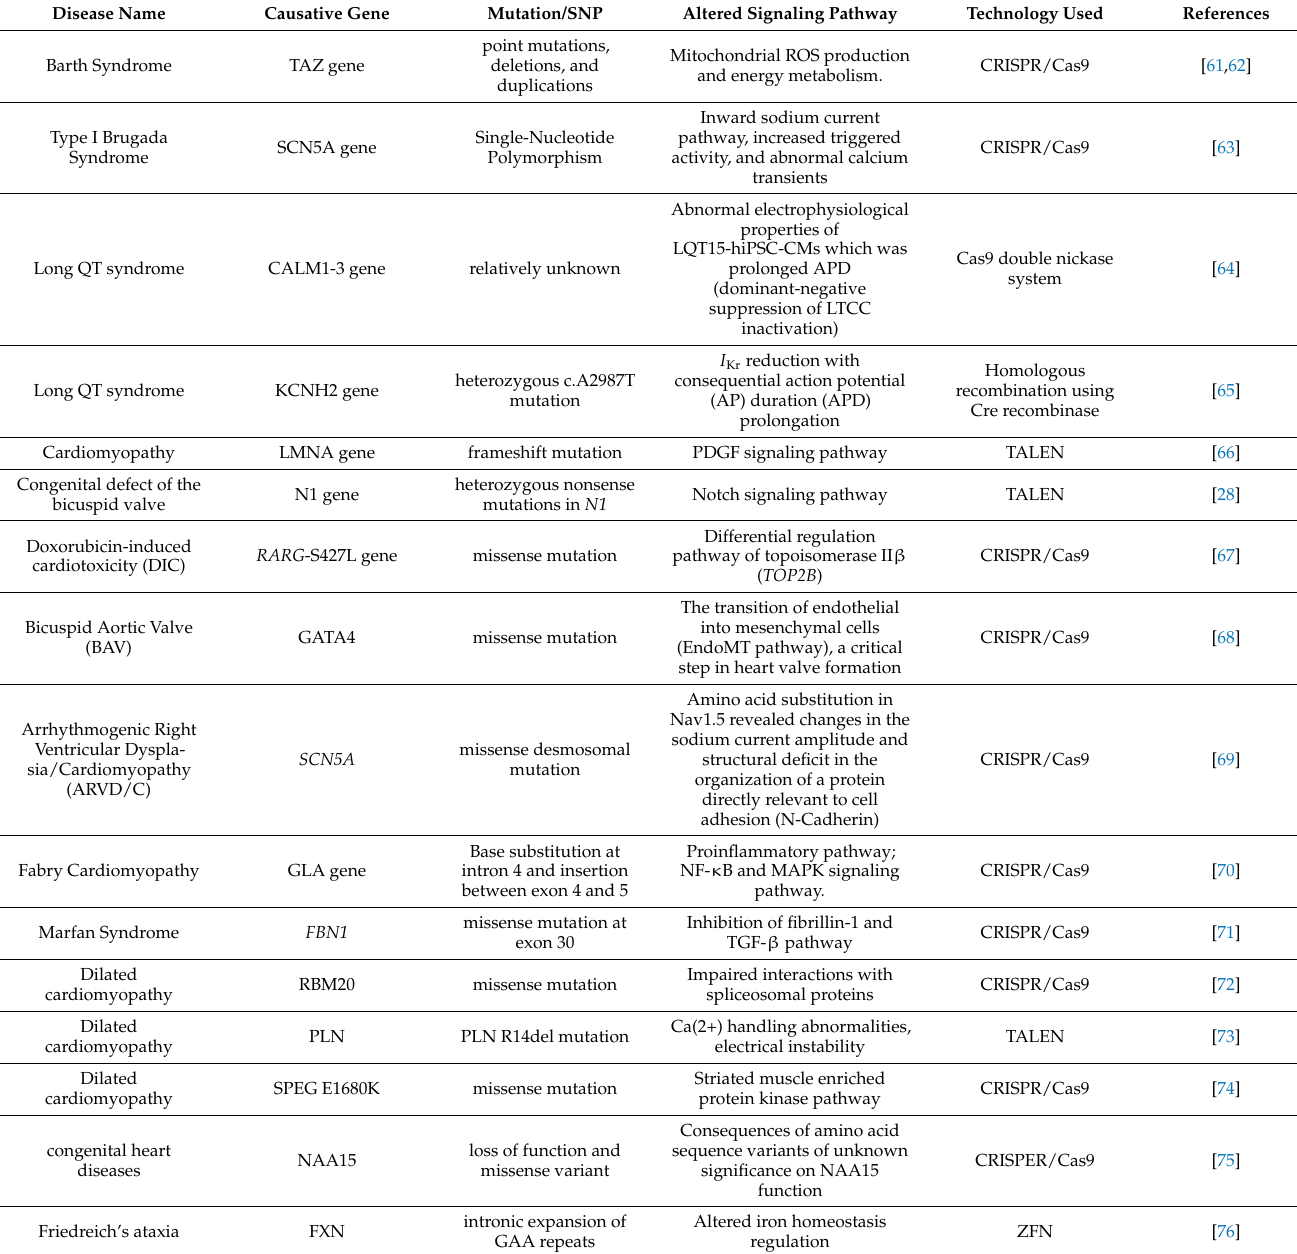
Table 2. List of cardiovascular diseases and their pathogenic variants identified from hiPSC-based disease modeling in combination with genome editing and NGS